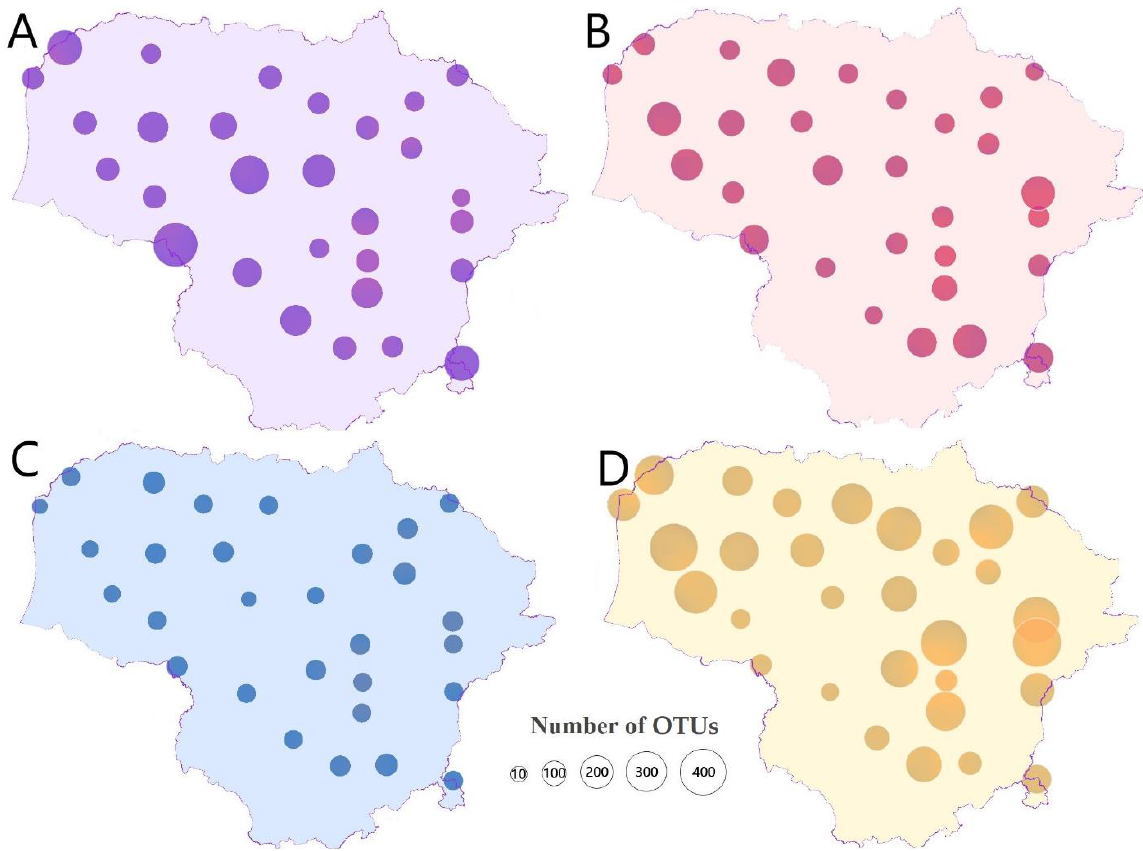
Figure 3. Map of Lithuania showing the richness of fungal OTUs associated with ( A ) needles, ( B ) shoots, ( C ) roots, and ( D ) the rhizosphere soil at different Picea abies sampling sites. By contrast, the species richness was significantly affected by variables reflecting the soil chemistry. The pH had a similar effect on shoot and root fungi — species richness decreased with increased pH. The opposite trend was for soil fungi, while species richness of fungi in needles remained generally unaffected (χ 2 = 73, df = 3, p < 0.05) (Figure 4A). The increase of species richness with increased P 2 O 5 was only in roots, while fungi in all other substrates showed the decrease of species richness with the increasing P 2 O 5 values (χ 2 = 108, df = 3, p < 0.05) (Figure 4B). The increasing concentration of K 2 O increased species richness in needles, but decreased in roots and soil, while fungi in shoots were generally unaffected (χ 2 = 252, df = 3, p < 0.05) (Figure 4C). The species richness increased in root and in the soil with the increasing concentration of salts, while the opposite was for needle and shoot fungi (χ 2 = 156, df = 3, p < 0.05) (Figure 4D).